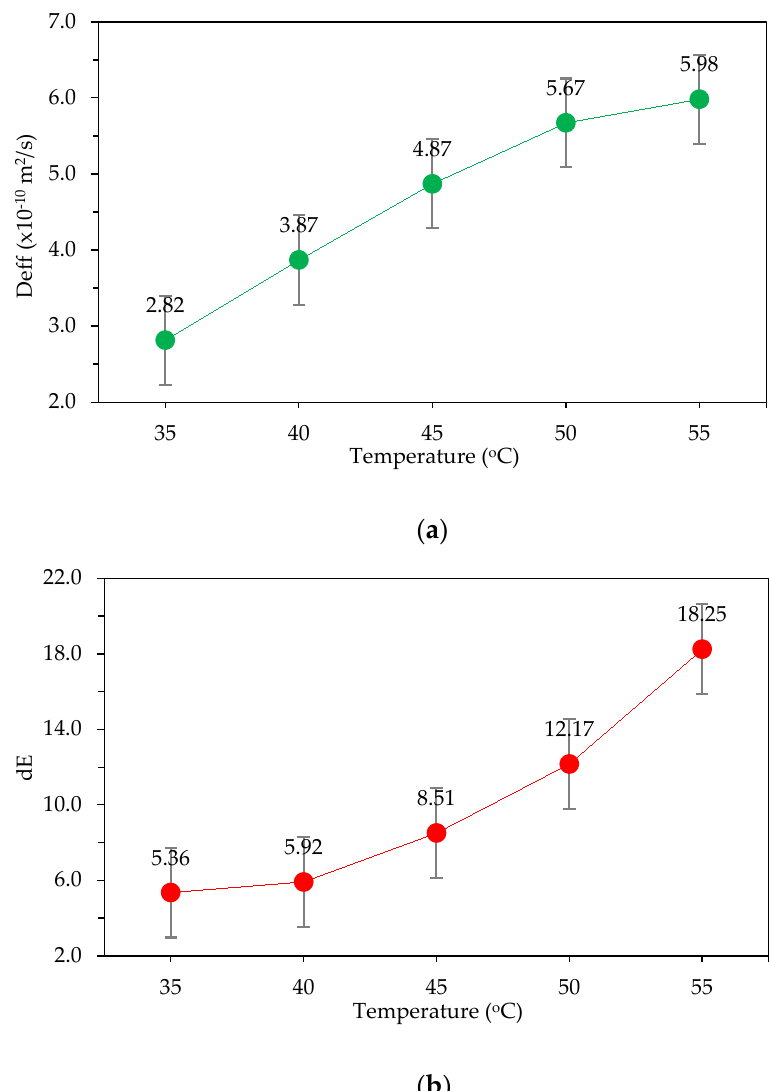
Figure 4. Effect of drying temperature on ( a ) moisture diffusion coefficient and ( b ) color change.